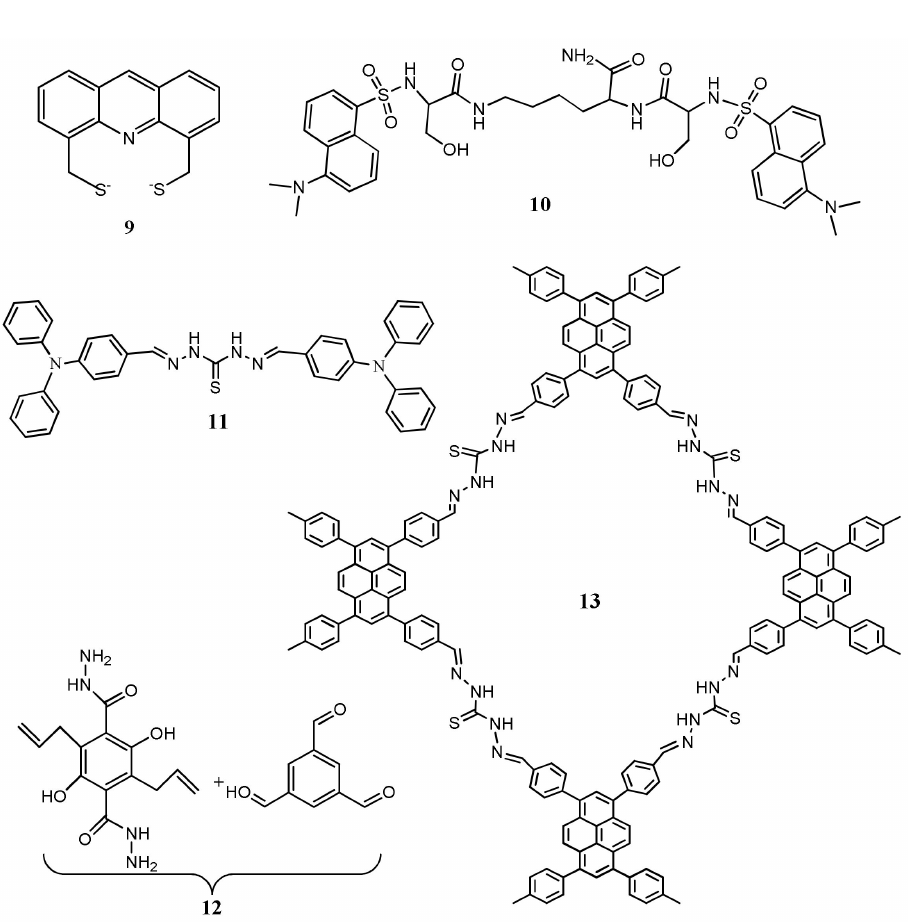
Figure 7. Molecular structures of the sensors 9 to 13